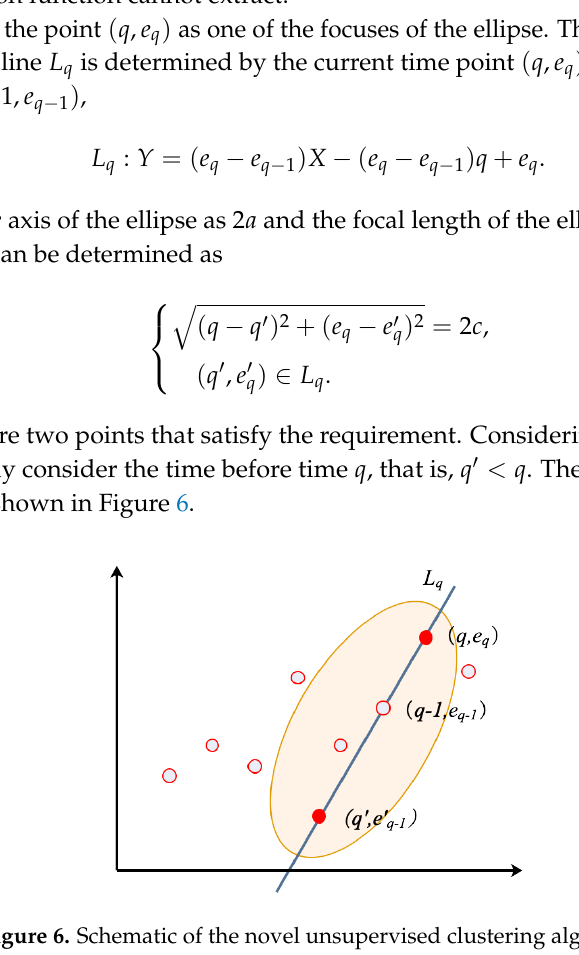
Figure 6. Schematic of the novel unsupervised clustering